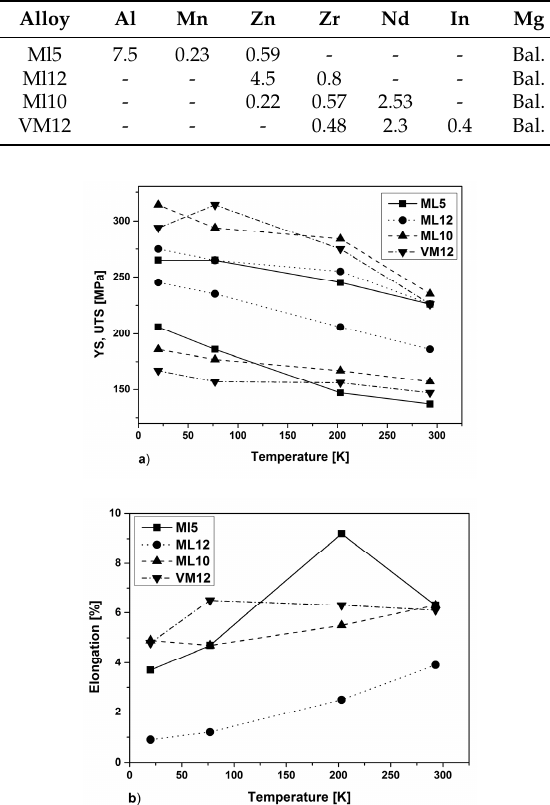
Figure 3. ( a ) Temperature dependent yield strength (YS) and ultimate tensile strength (UTS); and ( b ) temperature dependent elongation to fracture (after [17]).